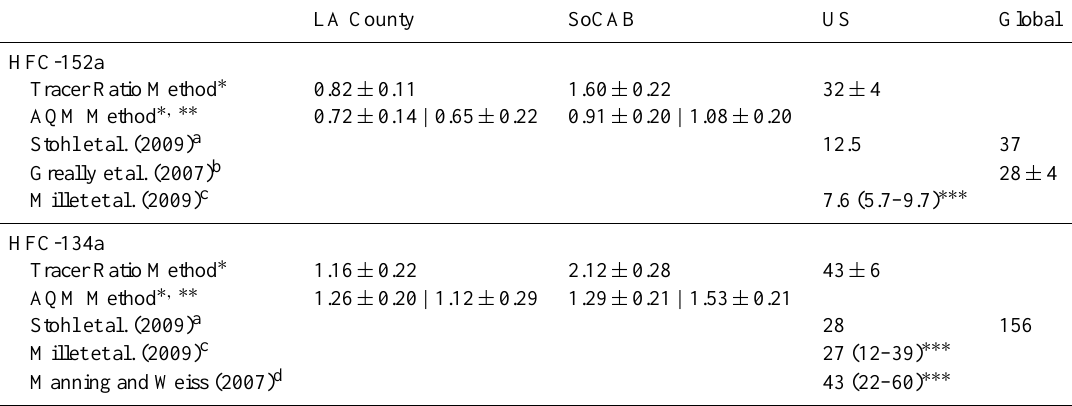
Table 4. A comparison of emissions estimates (in Ggyr − 1 ) of HFC-152a and HFC-134a from this study and previous